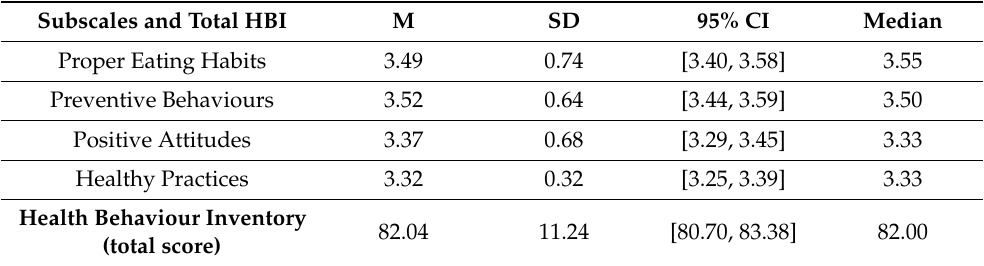
Table 2. Health Behaviour Inventory scores ( n = 275).